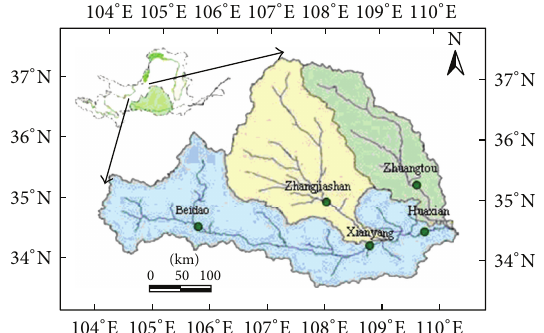
Figure 1: Map of the Weihe River Basin showing the five hydrolog- ical stations and corresponding